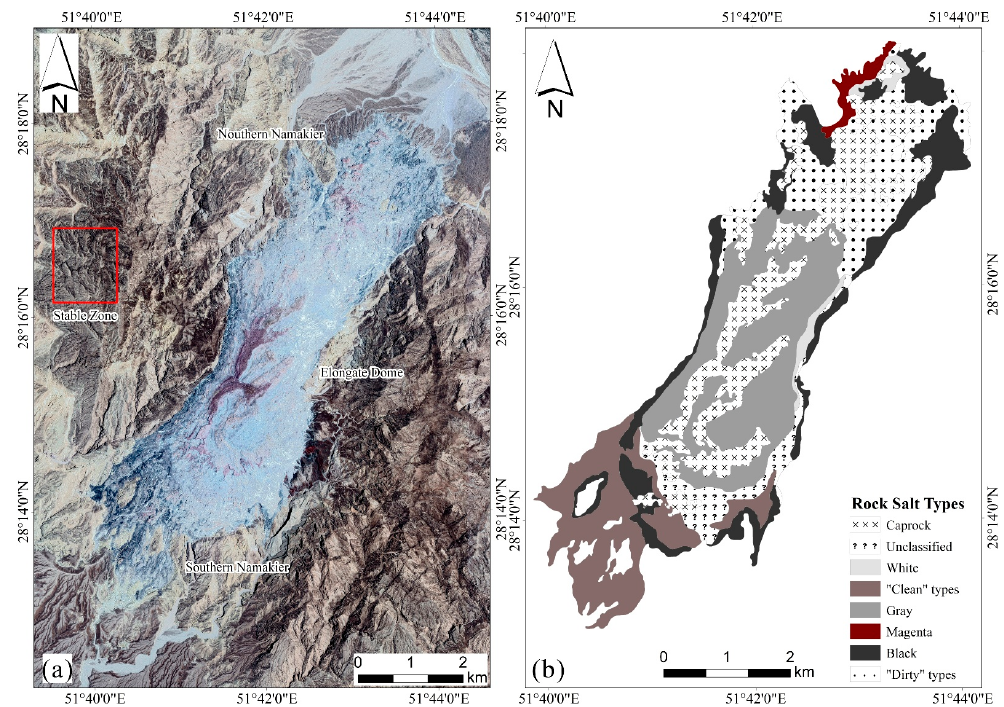
Figure 2. ( a ) Google Earth image of Kuhe-e-Namak (Dashti) namakier. The red rectangle indicates the stable zone used to correct the errors in image registration. ( b ) Distribution of rock salt types in Kuh-e-Namak (Dashti) (modified from [12]).